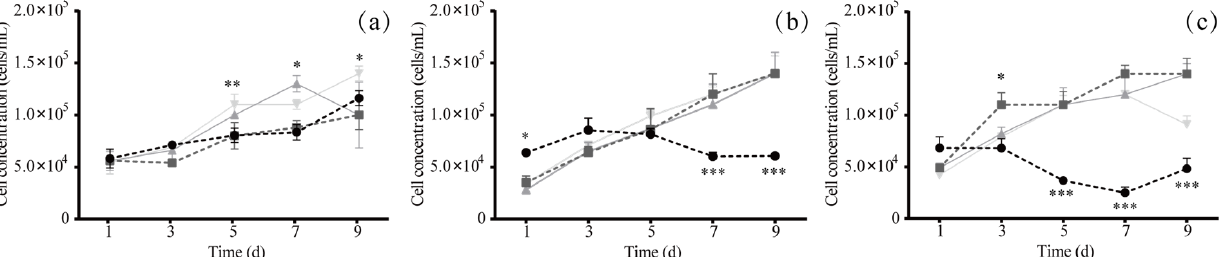
Figure 6. Cell concentration curves of H. lacustris under light intensities of ( a ) 18 μ mol/m 2 ·s, LL; ( b ) 55 μ mol/m 2 ·s, ML; ( c ) 110 μ mol/m 2 ·s, HL. Continuous light (black circle), 2/2 s (black box), 2/2 h (gray triangle), 6/6 h (gray inverted triangle). Error bars show the standard deviation for three replicates. Asterisks indicate statistically significant differences resulting from Student’s t -tests: * p < 0.05, ** p < 0.01, *** p <0.001.